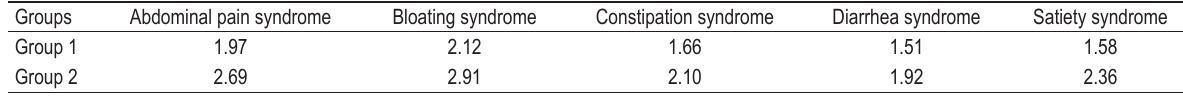
GSRS: Gastrointestinal symptom rating